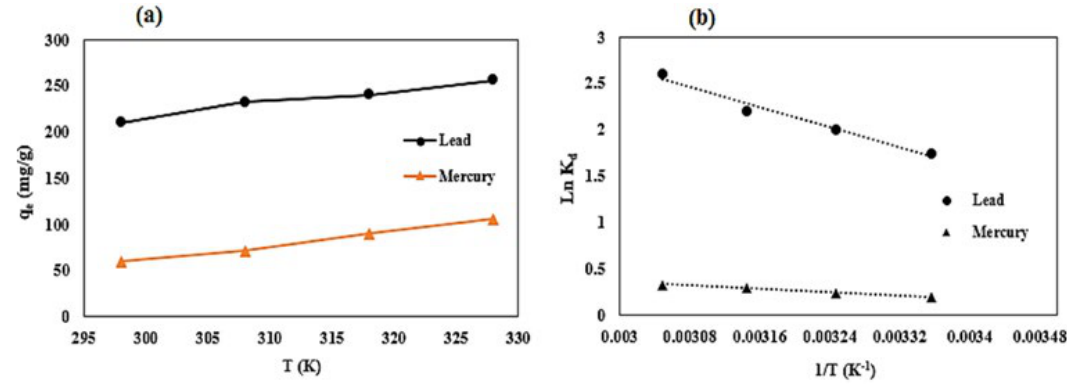
Fig. 9. Effect of temperature on (a) adsorption capacity and (b) Van’t Hoff plot